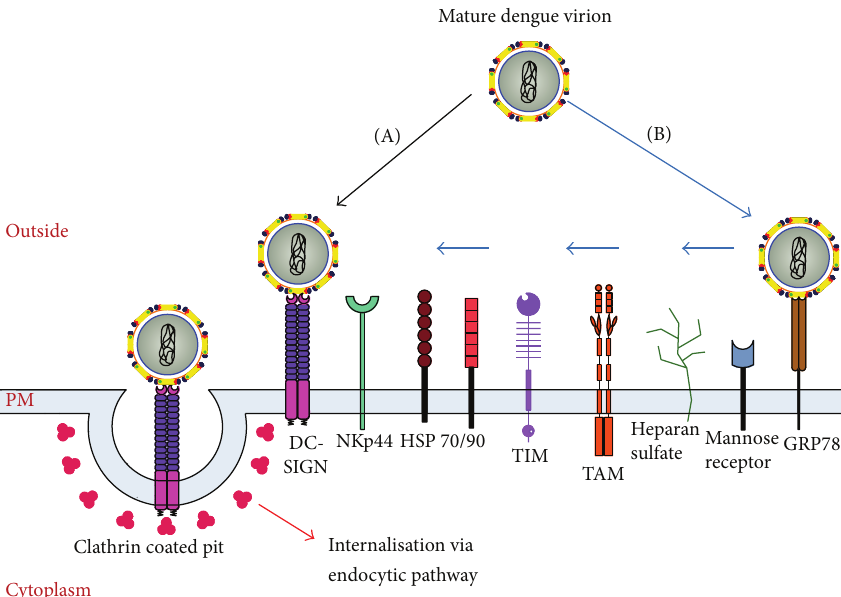
Figure 4: Schematic representation of the dengue virus entry process. The dengue virus makes use of membrane receptors and attachment factors on the cell plasma membrane (PM) to find its way to the cytoplasm. The mature virion either gets attached directly to a cellular membrane receptor (a) or uses several attachment factors (b) to finally trigger the endocytic, clathrin dependent pathway. The endocytic vesicle becomes a late endosome, where acidification triggers conformational changes on the E protein dimers to become fusogenic trimers. Finally, pores are formed and the genome of the virus is released into the